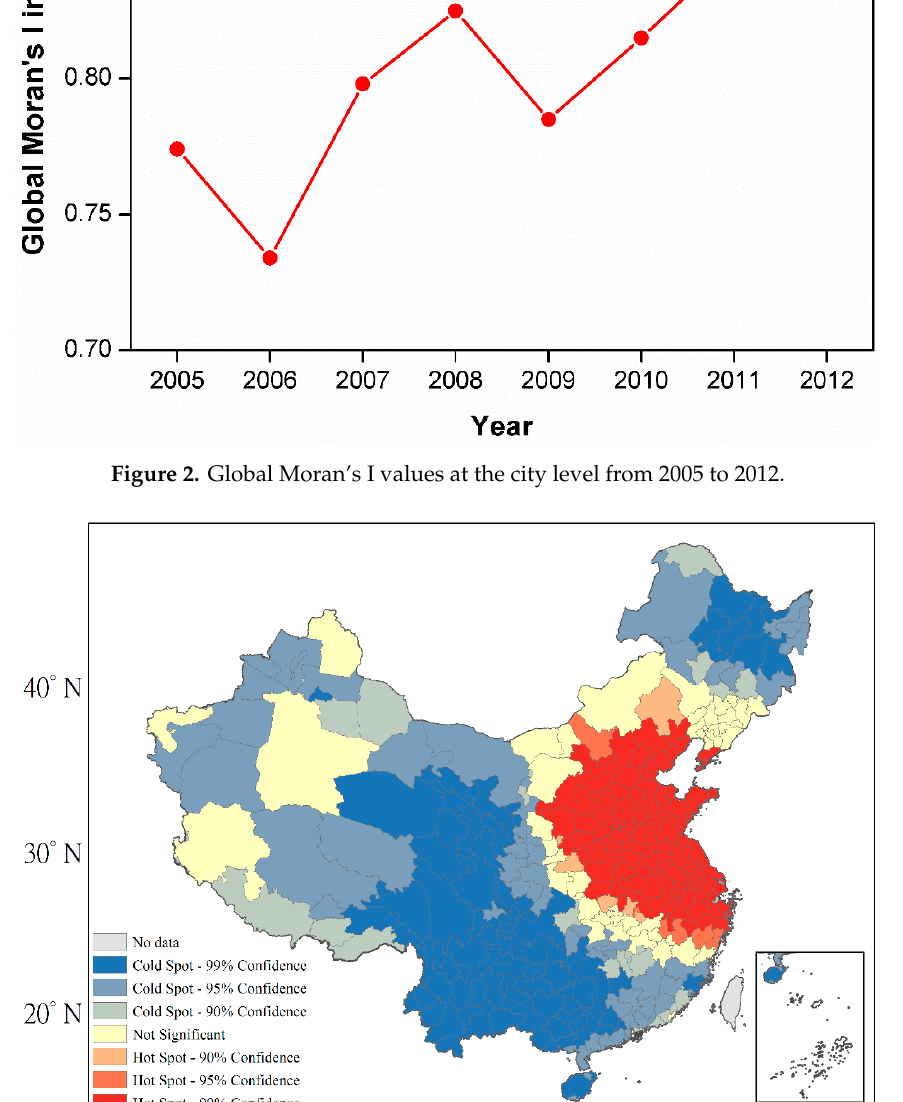
Figure 3. Hot-spot analysis over China in 2012.